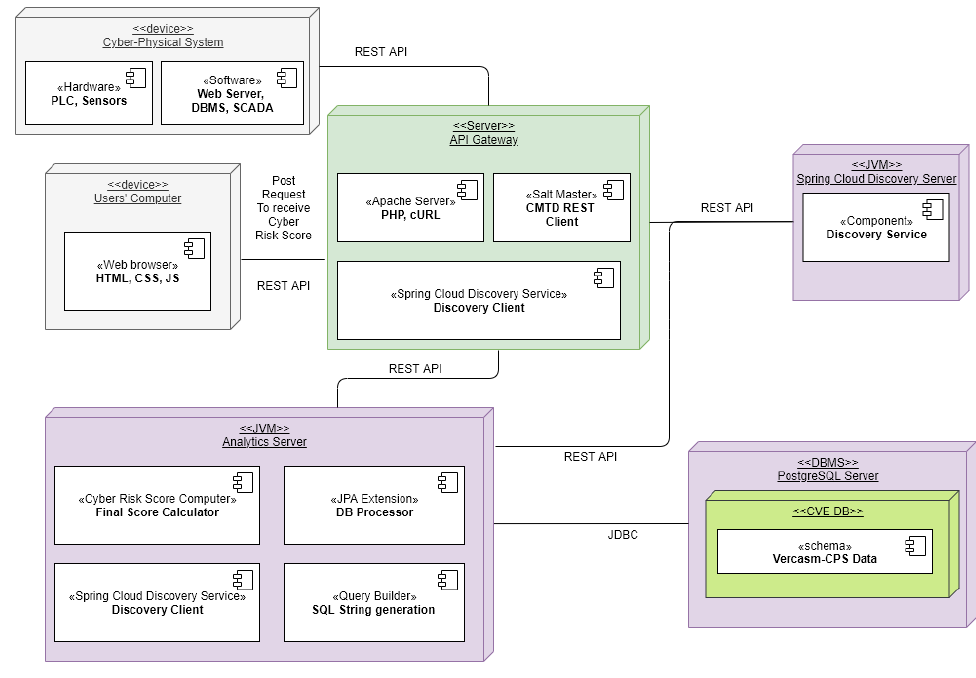
Figure 1. UML Diagram of VERCASM-CPS.